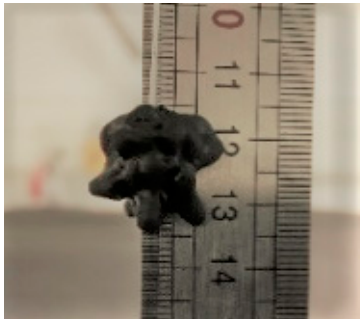
Figure 5 . The tumor phantom: microlobulated shape, average radius of 14 mm, dielectric properties matching the measured dielectric properties of excised malignant tissue. Two snapshots from the preparation of the experimental setup, before a typical validation test of the device, are shown in Figure 6.